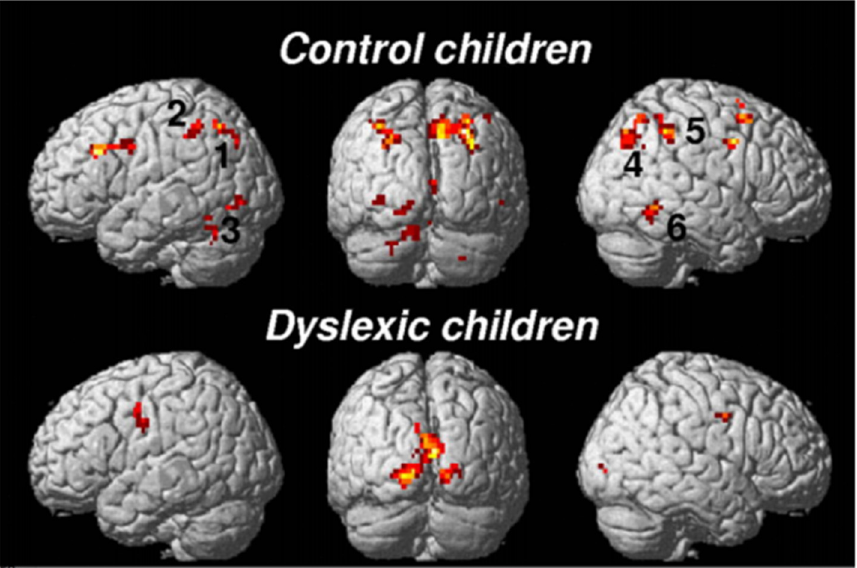
Figure 4. FMRI activations during the flanked condition of the categorization task in Peyrin et al. [44]: underactivation of the superior parietal cortex bilaterally in typical visuo-attentional dyslex- ics.